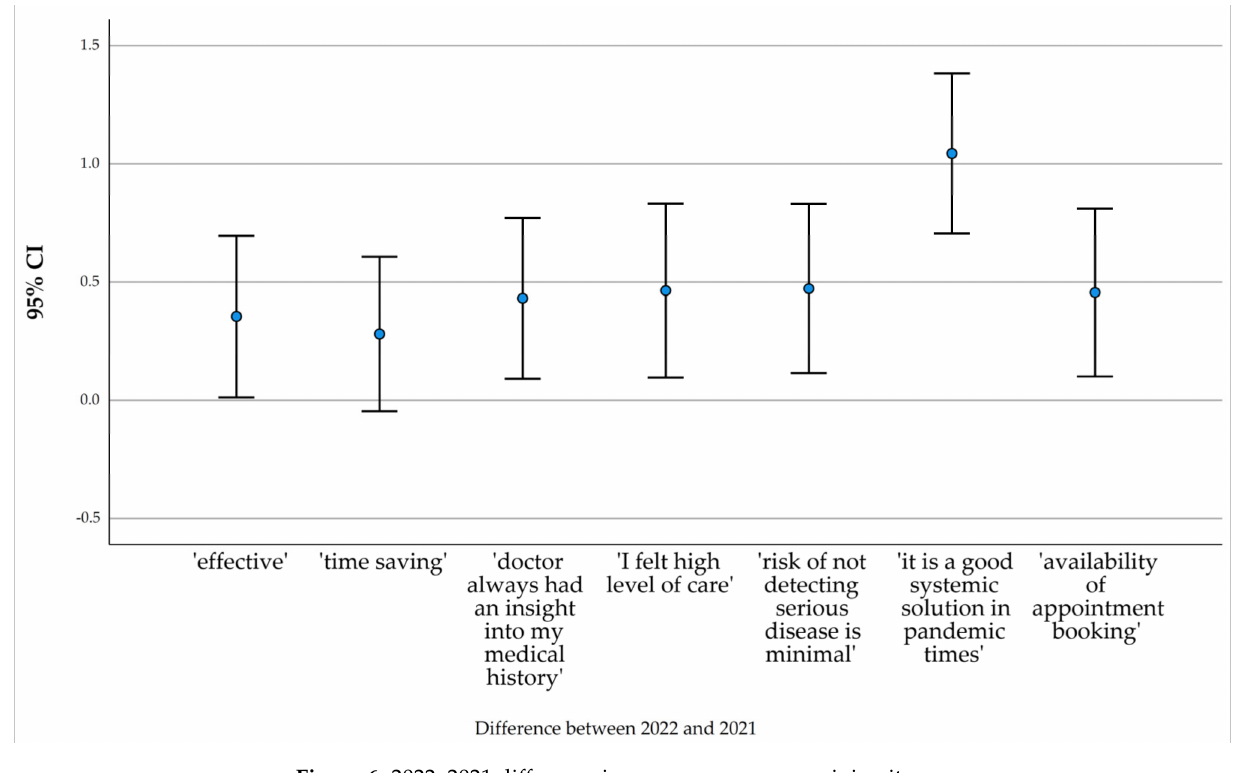
Figure 6. 2022–2021 difference in average score per opinion item. Table 4. Univariate and Multivariate Linear Regression of Average Opinion on telemedicine after two years of the